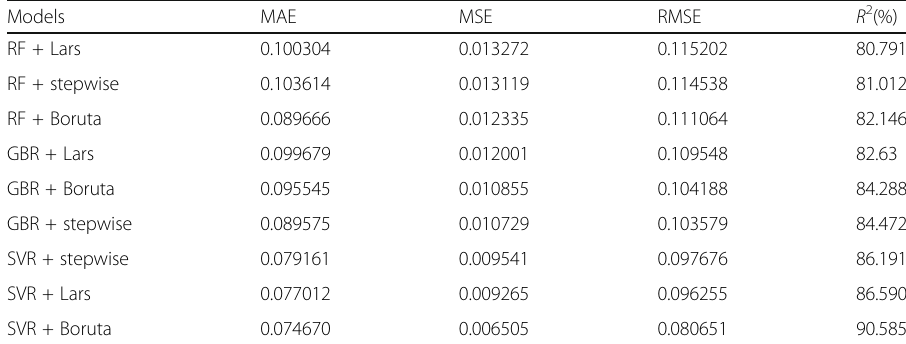
Table 5 The prediction performance of nine different hybrid models